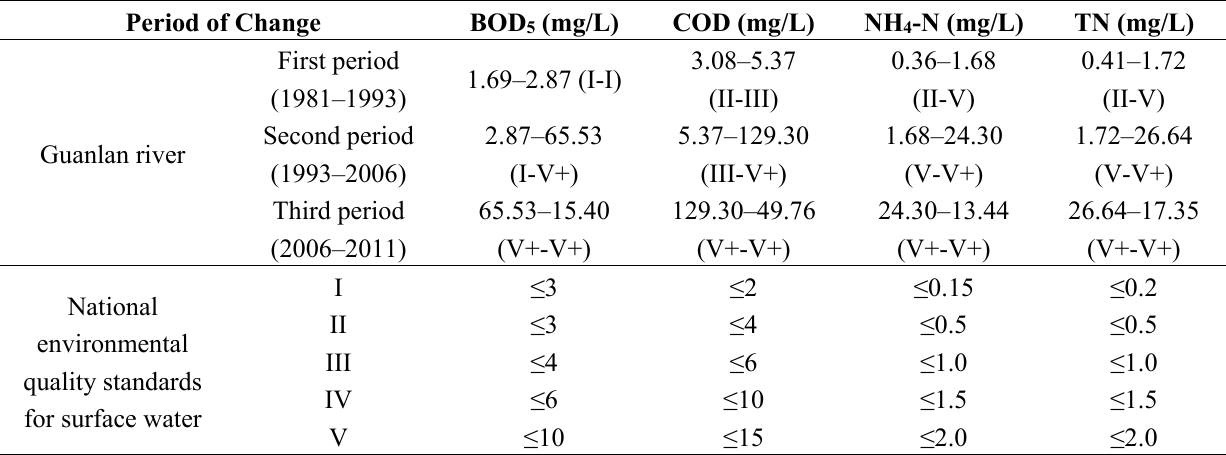
Table 2. Water quality in the Guanlan River during the 30-year period between 1981 and 2011. Data for 1981–2006 were collected from the literature [18–23]. The 2011 data were obtained from the sampling